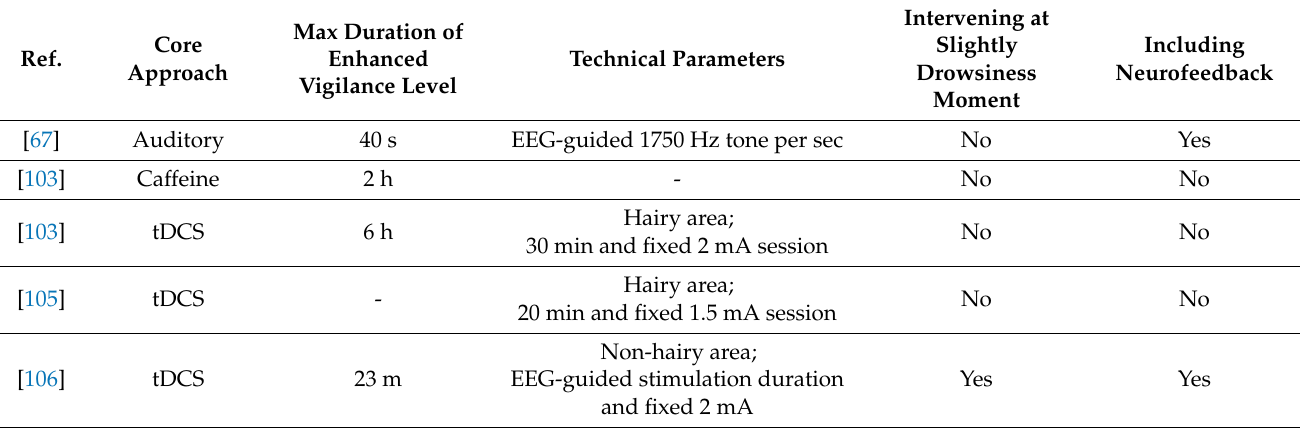
Table 9. Performance Comparison of Approaches for Vigilance